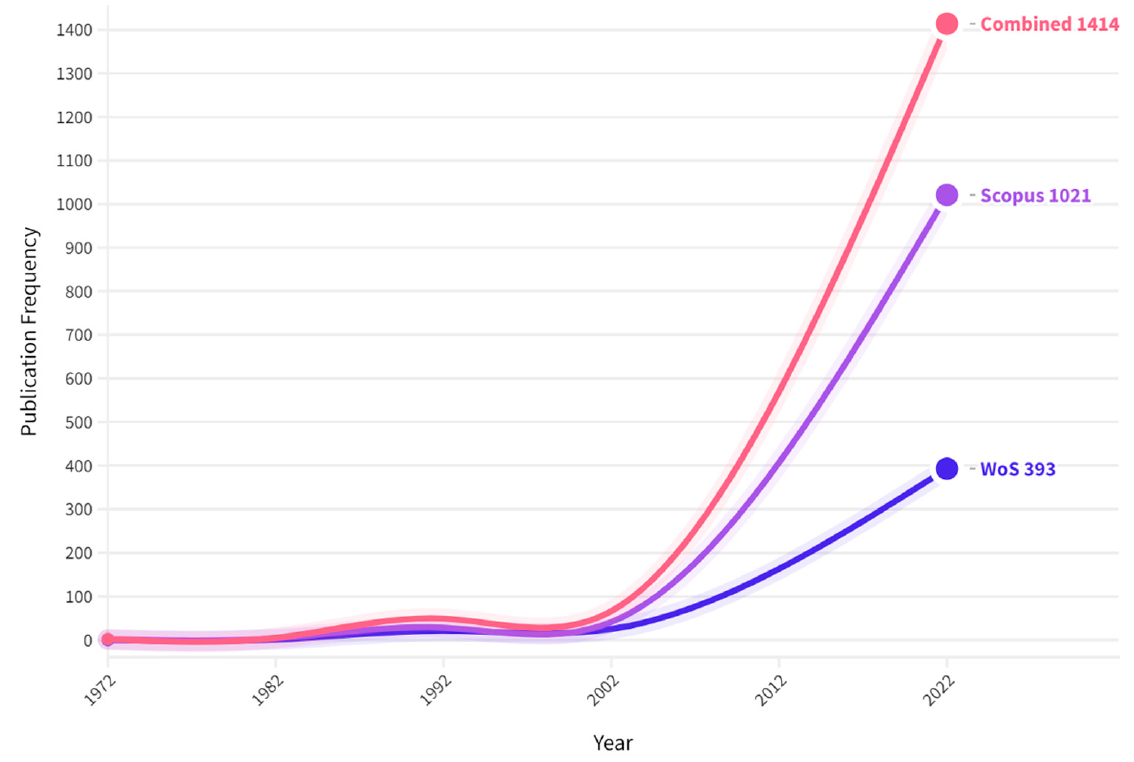
Figure 4. Trends and numbers of published articles on mangrove sediment microbial studies in two main databases. Publication counts skyrocketed in early 2000.